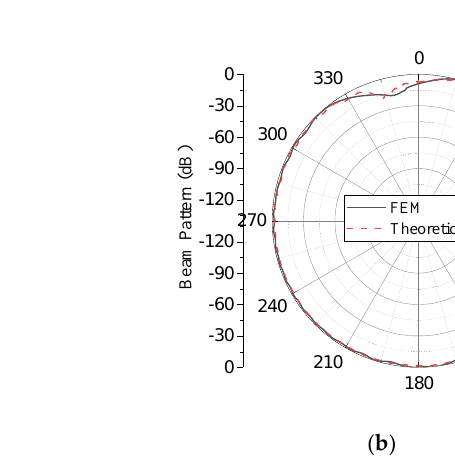
Figure 9. Comparison of the theoretical and finite element analysis beam patterns of the GFA: ( a ) elevation plane; ( b ) azimuth plane. Table 4. Comparative values of the performance outputs of the theoretical and finite element anal- ysis beam patterns of the GFA.